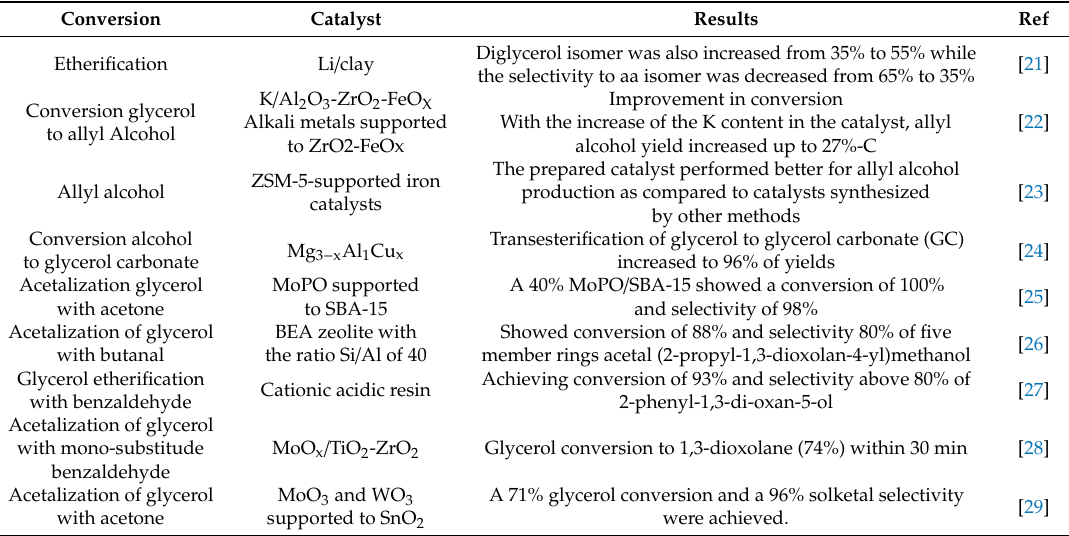
Table 1. Di ff erent conversion routes from glycerol to value-added